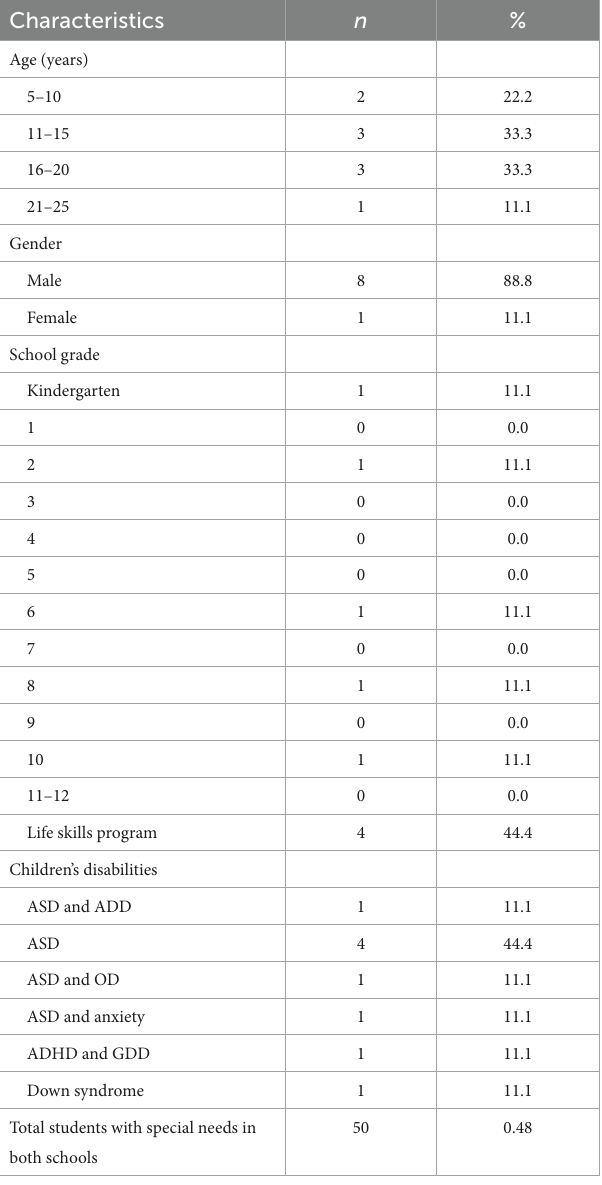
TABLE 2 Characteristics of participant’s children with